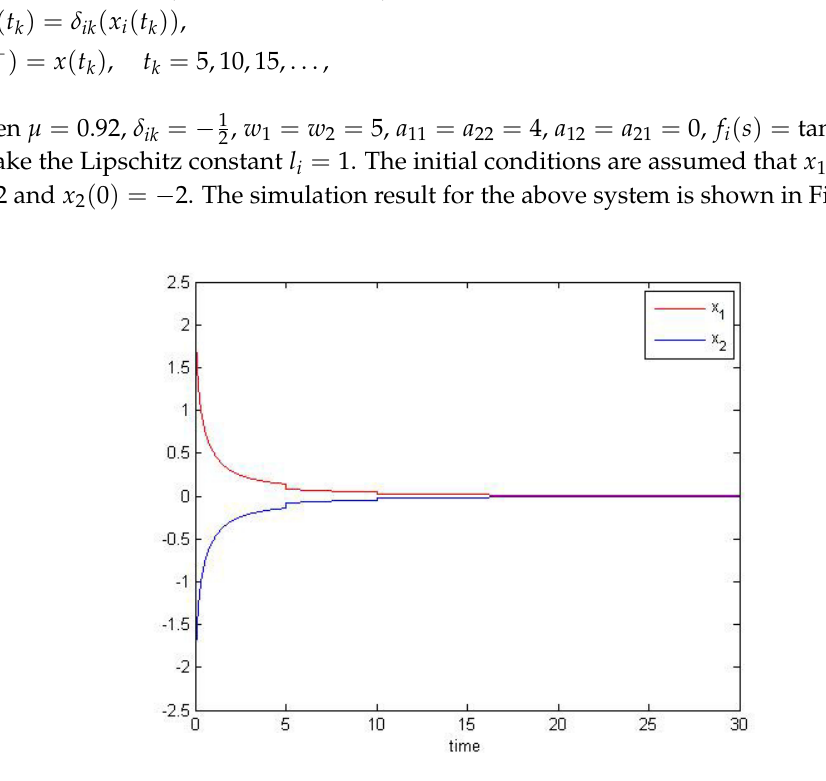
Figure 3. Dynamical behaviors of states x 1 ( t ) and x 2 ( t ) under above parameters.